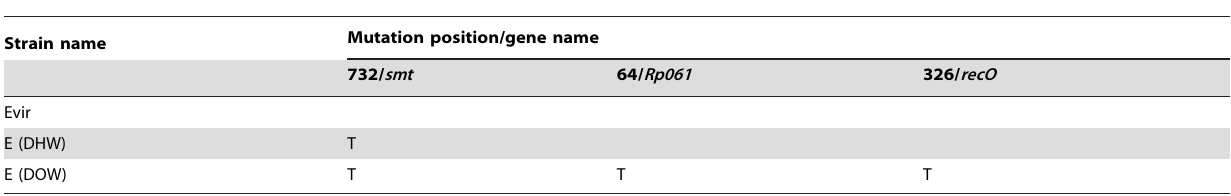
Table 1. Mutation in Madrid E strains of R. prowazekii